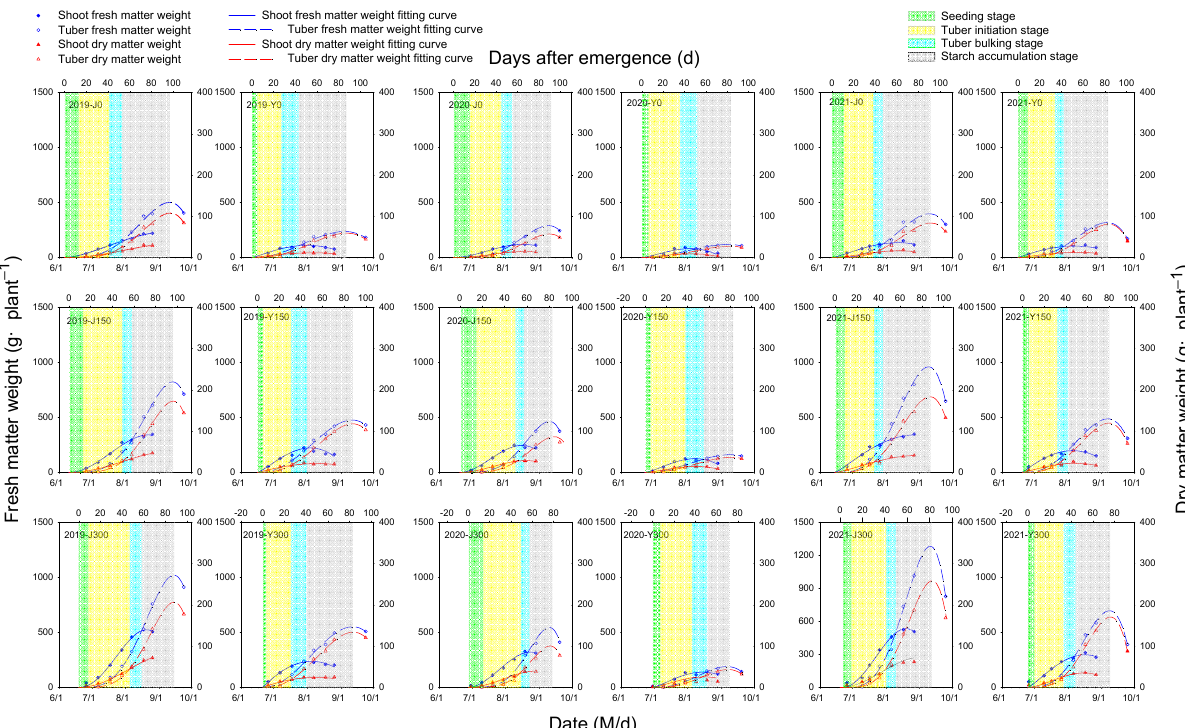
Figure 3. Actual dry and fresh weight and their corresponding fitting curves of two potato varieties at different nitrogen application rates. The year and treatment are noted in the upper left corner of the figure. Points are measured value; lines are fitting curve; shaded areas are growth stage. The fi tt ing curve parameters are recorded in Tables 4 and 5.